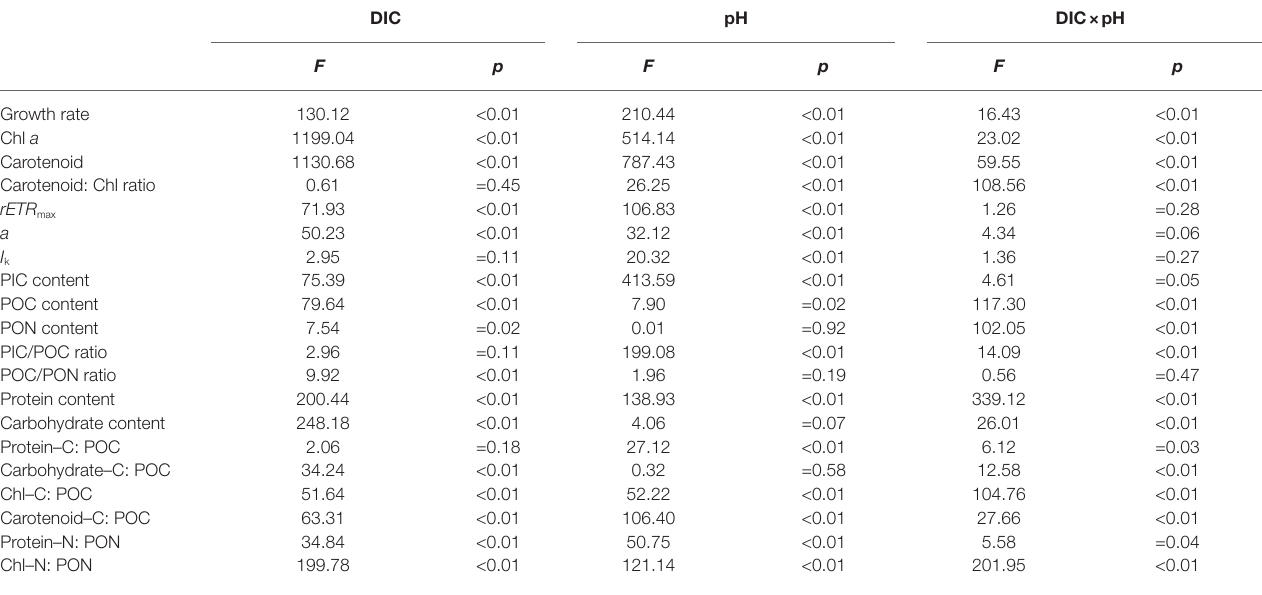
TABLE 2 | Results of two-way ANOVAs of the effects of dissolved inorganic carbon (DIC) and pH and their interaction on growth rate, chlorophyll a (Chl a ) and carotenoid contents, carotenoid: Chl ratio, rETR max , light use efficiency ( a ), saturating light intensity ( I k ), PIC, POC and PON contents, PIC/POC and POC/PON ratios, protein and carbohydrate contents, the percentages of protein–carbon to POC (Protein–C: POC), carbohydrate–carbon to POC (carbohydrate–C: POC), Chl–carbon to POC (Chl–C: POC) and carotenoid–carbon to POC (Carotenoid–C: POC), and the percentages of protein–nitrogen to PON (Protein–N: PON) and Chl–nitrogen to PON (Chl–N: